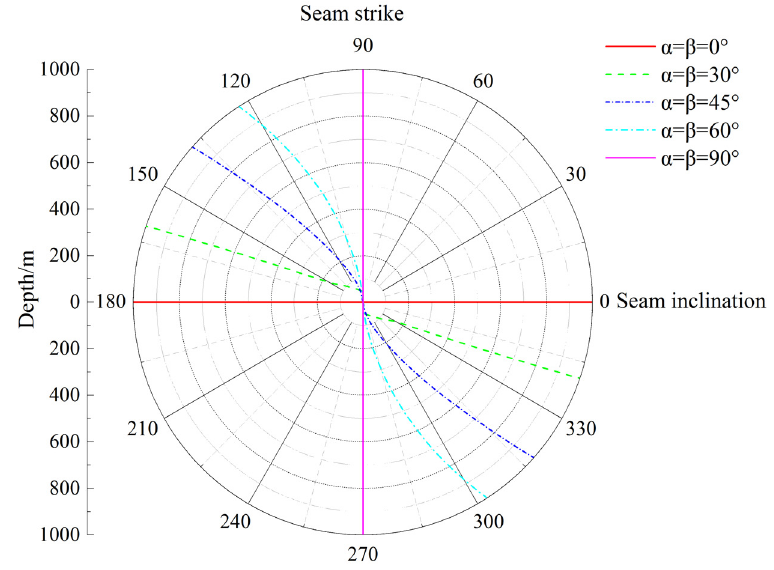
Figure 10. Relationship between the initial cracking location and burial depth.